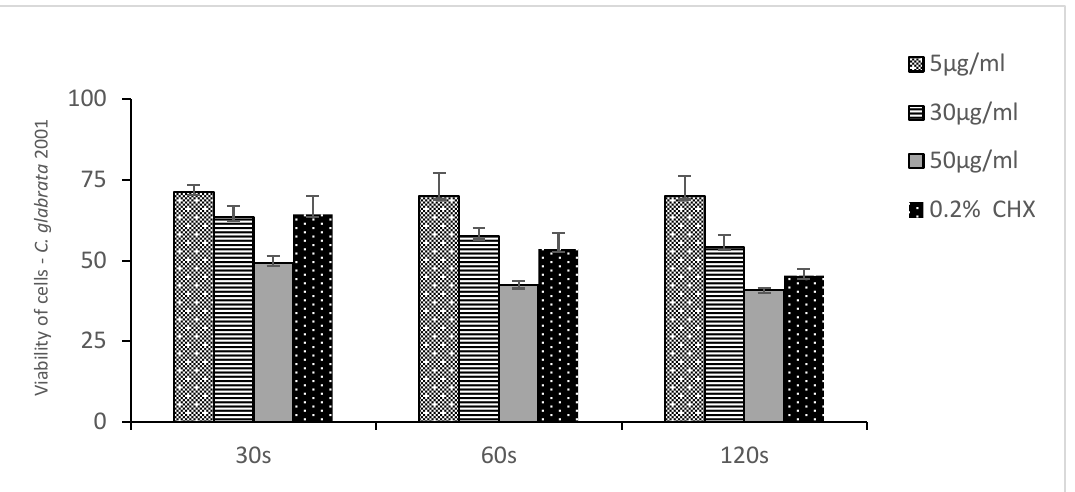
Figure 2. Viability of cells of Candida albicans ATCC 10,231 to ozonated water and chlorhexidine after three exposure times. n = 8 where n is the number of independent replications.